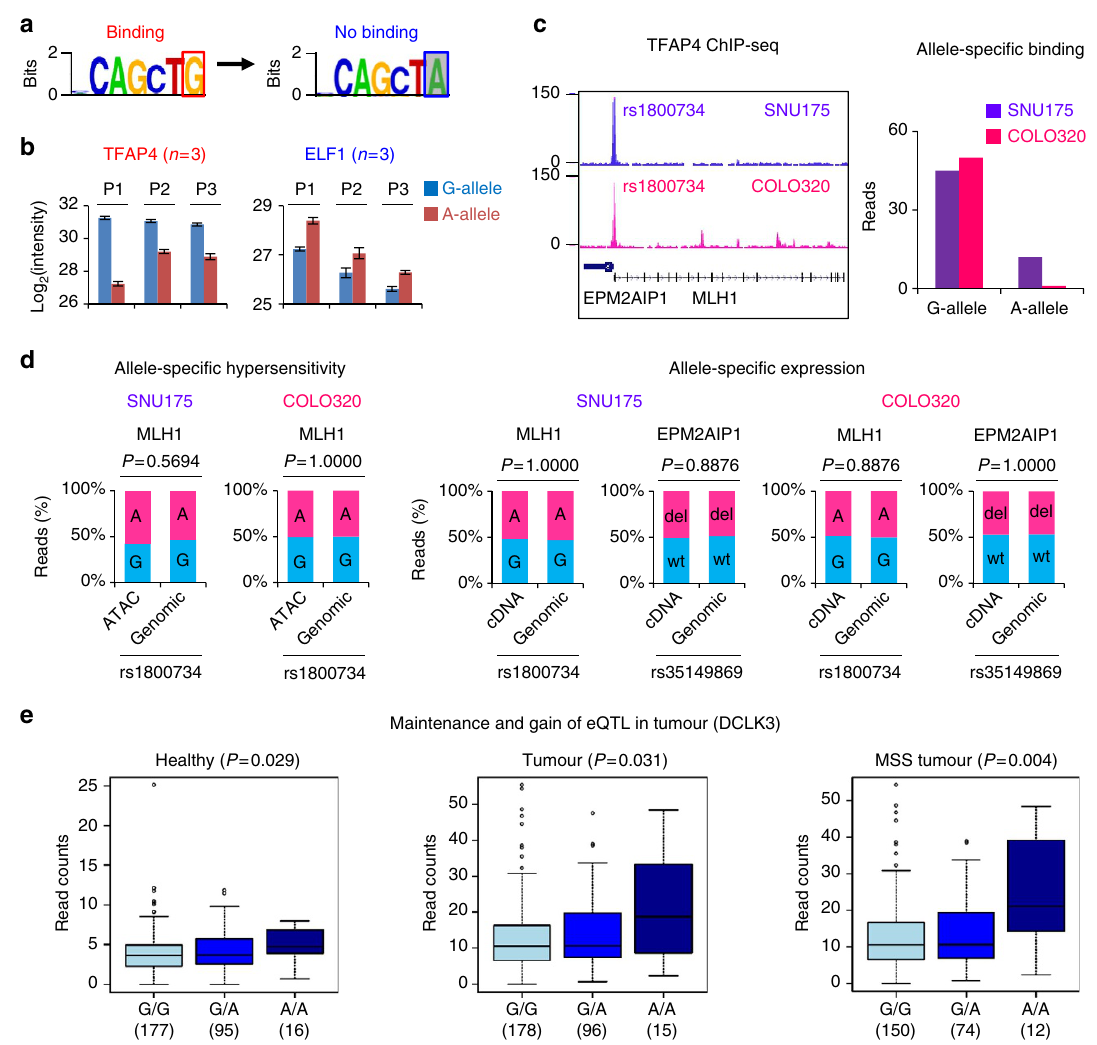
Figure 2 | Identification of allele-specific interactors for rs1800734 and its potential gene targets. ( a ) Motif analysis interpreted that A-allele of the loci perturbs E-box motif. ( b ) The specific binding of TFAP4 (P1 ¼ 2.0 (cid:2) 10 (cid:3) 6 , P2 ¼ 3.1 (cid:2) 10 (cid:3) 5 , P3 ¼ 7.8 (cid:2) 10 (cid:3) 5 , Student’s t -test) and ELF1 (P1 ¼ 2.1 (cid:2) 10 (cid:3) 4 , P2 ¼ 0.011, P3 ¼ 6.9 (cid:2) 10 (cid:3) 4 , Student’s t -test) on G- and A-allele was observed in the three different cell lines (data are represented as mean and error bars indicate s.d., n ¼ 3 pulldowns per SNP). ZFP62 binding on A-allele, as shown in Fig. 1d, was not consistent in all the three cell lines and was hence not considered as the general TF regulator at this locus. ( c ) This allele-specific binding was validated by ChIP-seq of TFAP4. This SNP did not change ( d ) the local chromatin accessibility and the expression of two cis -regulated genes ( MLH1 and EPM2AIP1 ) (G (G-allele) and A (A-allele) of rs1800734, wt (wild-type allele) and del (deletion allele) of rs35149869, P -values: Fisher’s exact test). ( e ) eQTL analysis revealed a novel gene targets DCLK3 of this SNP ( P -values were calculated in FastQTL software based on linear regression